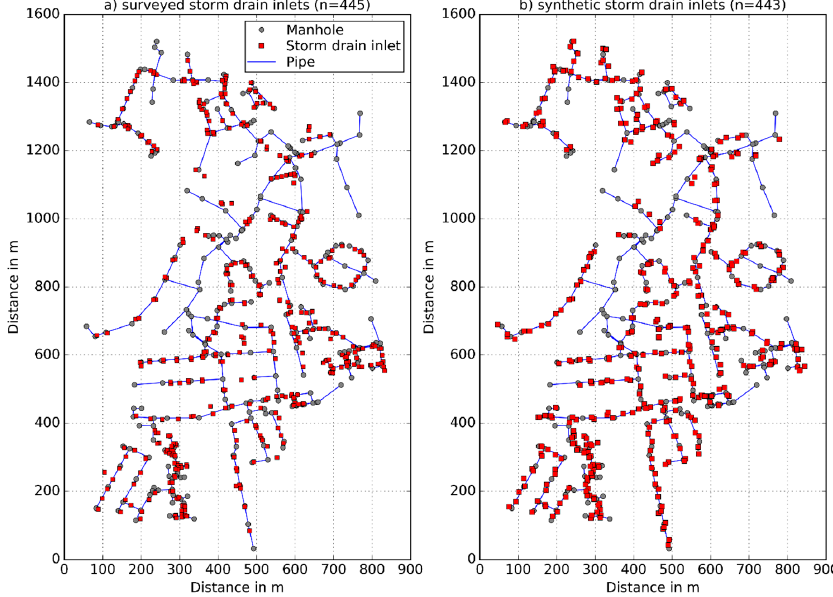
Figure 8. Surveyed storm drain inlet network ( a ) and synthetic storm drain inlet network final version ( b ).